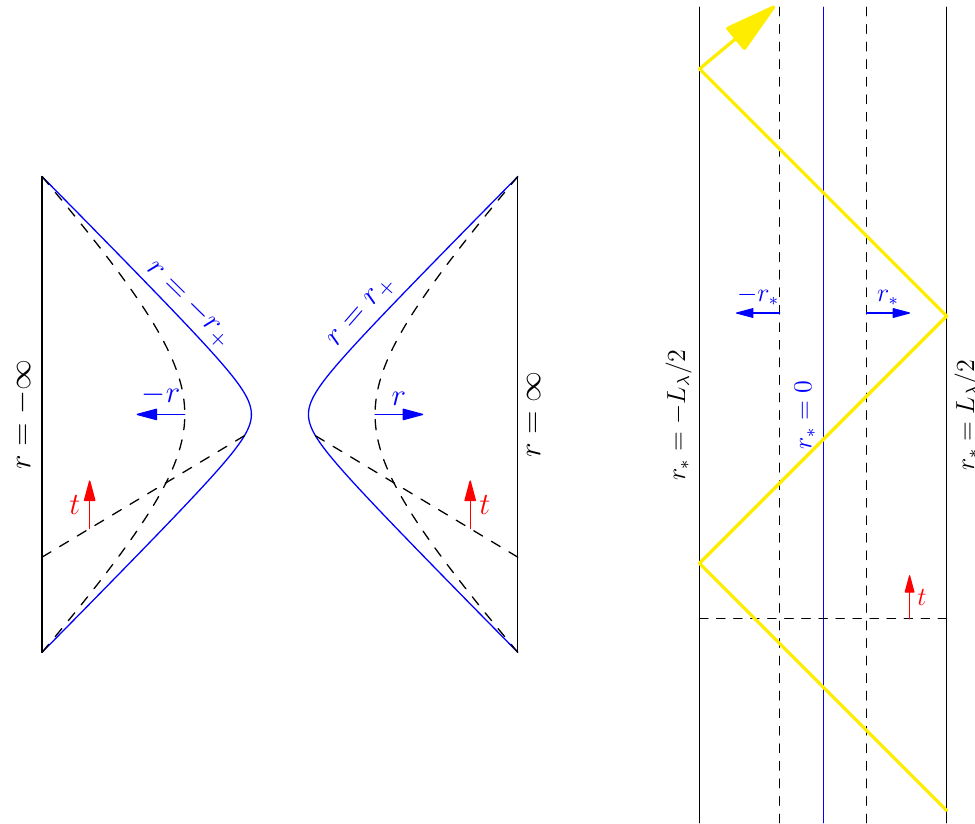
Figure 2. Conformal diagrams of the Lorentzian non-rotating wormhole in terms of r (left) and r ∗ (right) coordinates. In the r coordinate we see that the wormhole is created by a left and a right BTZ wedge glued together (the blue solid line) slightly outside of the BTZ horizon. The r ∗ coordinate, which ranges continuously in [ − L λ / 2 , L λ / 2] , makes the causal structure more apparent: the glued surfaces r = ± r + (on the left) both coincide with the surface r ∗ = 0 (on the right). The gluing is smooth and a radial light-ray (yellow) can explore the entire wormhole by bouncing infinitely many times between the two boundaries. The diagrams are the same as in